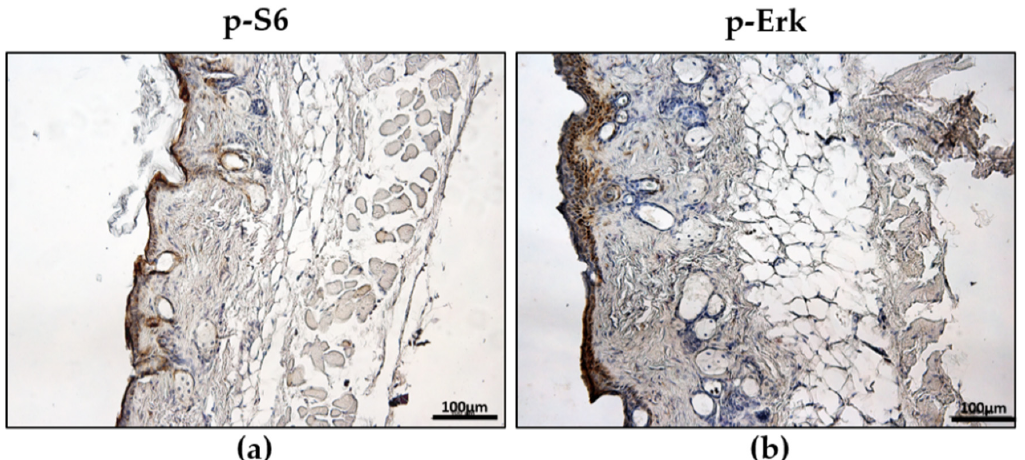
Figure 4. Representative immunohistochemistry for phospho-S6 ( a ) and phospho-Erk ( b ) positivity in the skin of TSC2 -/meth -cells-injected mice after treatment with 5-azacytidine for 4 days. Nuclei are stained with hematoxylin. Scale bar: 100 µ